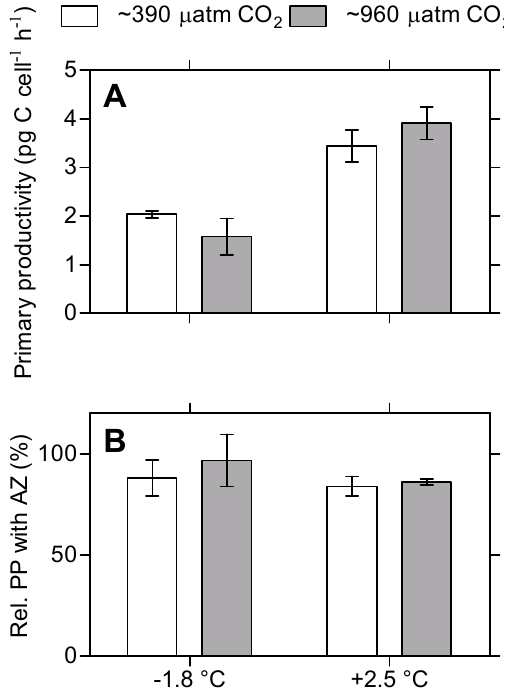
Fig. 3. (A) Primary productivity (pg C h − 1 cell − 1 ) measurements after 14 days of treatment in Experiment A. (B) Relative primary productivity (PP) rates after addition of carbonic anhydrase in- hibitor acetazolamide (AZ). Carbon fixation is expressed in % in relation to samples incubated without inhibitor. Incubations were performed after 14 days of treatment in Experiment A. Error bars are displaying standard error ( n =